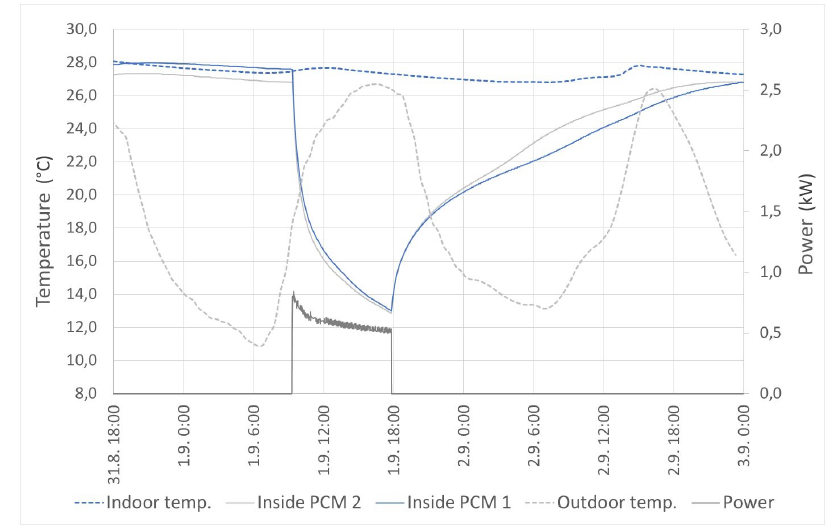
Figure 15. Active mode: thermoelectric cooling.